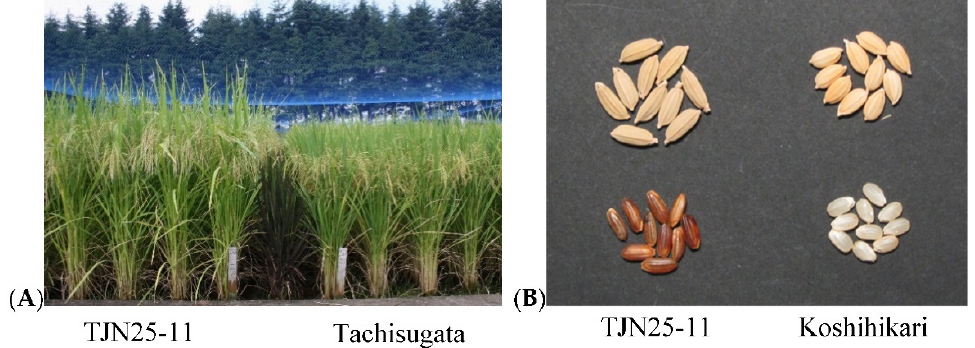
Figure 2. Plant shape ( A ) of TJN25-11 and Tachisugata and grain shapes ( B ) of TJN25-11 and Koshihikari grown in the field.